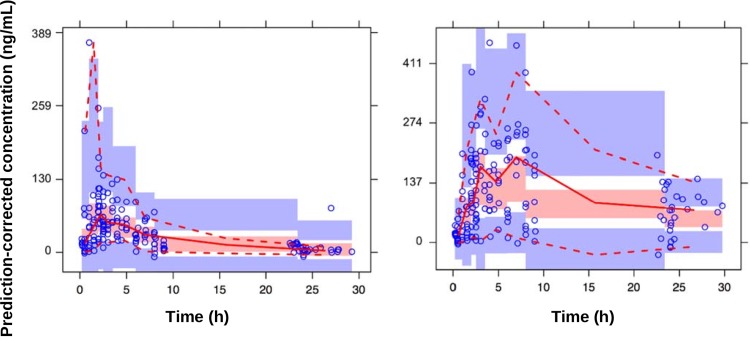
Prediction-corrected visual predictive check of observed data. The left and right panels depict the prediction-corrected visual predictive checks for PQ and C-PQ, respectively, based on 1,000 simulations. Prediction-corrected simulated (shaded areas) and observed (circles and lines) PQ and C-PQ concentrations are presented over time (h; y axes). The thick red line connects the observed median values per bin. The dotted red lines connect the 5th and 95th percentiles of the observations. The light blue areas are the 95% confidence interval of the 5th and 95th percentiles, and the light red area indicates the confidence interval of the median.